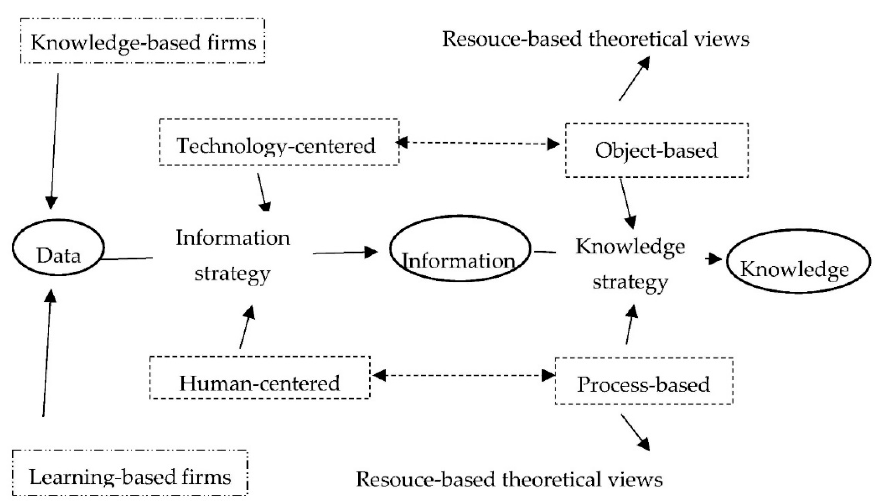
Figure 3. Converting data into knowledge .